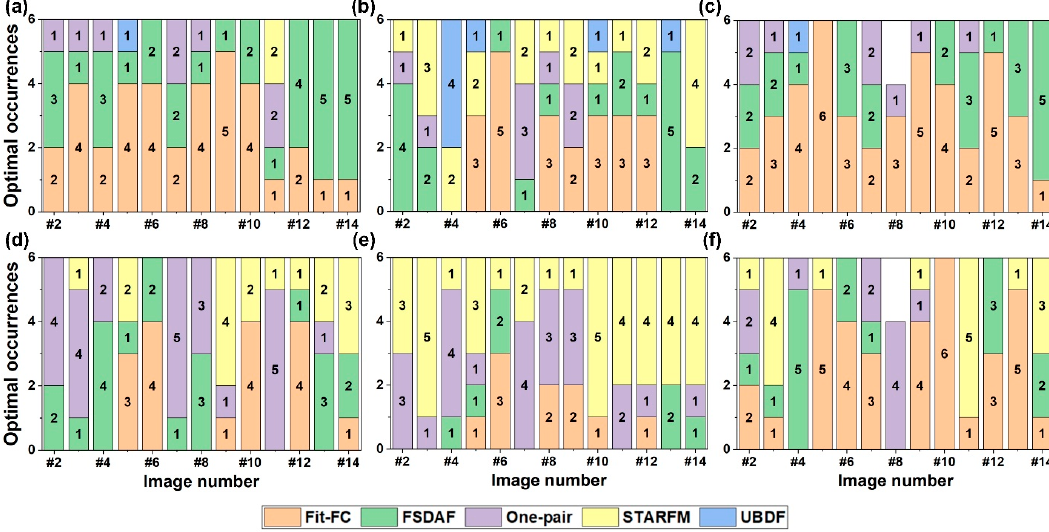
Figure 10. Occurrences of optimal STIF models for “HH” blocks ( a and d ), “HL” blocks ( b and e ) and “LH” blocks ( c and f ) evaluated using ERGAS (top row) and SSIM (bottom row) at the Gwydir site.